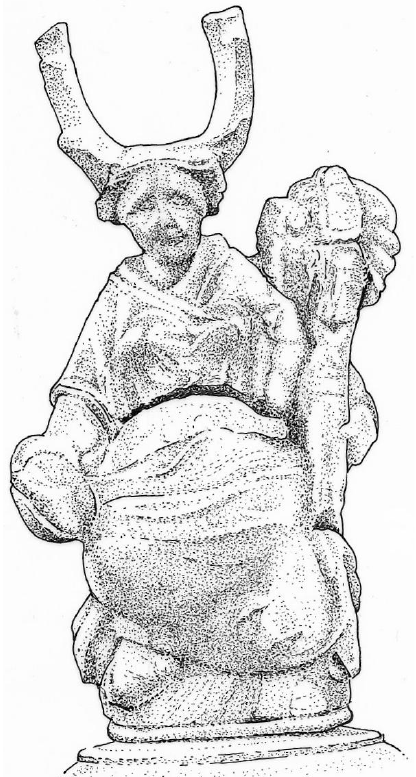
Figure 7. Gallo-Roman figurine of an antlered goddess. Provenance uncertain but thought to be from the region of Clermont-Ferrand, Auvergne.